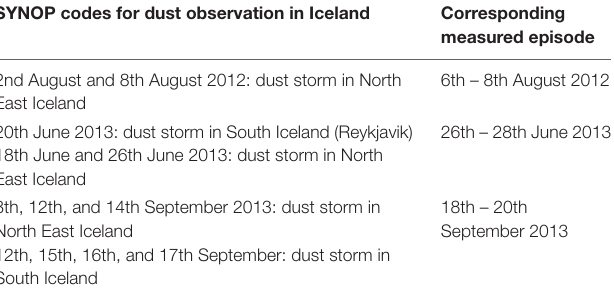
TABLE 5 | Dust storm occurrence for selected periods in Iceland in 2012 and 2013.